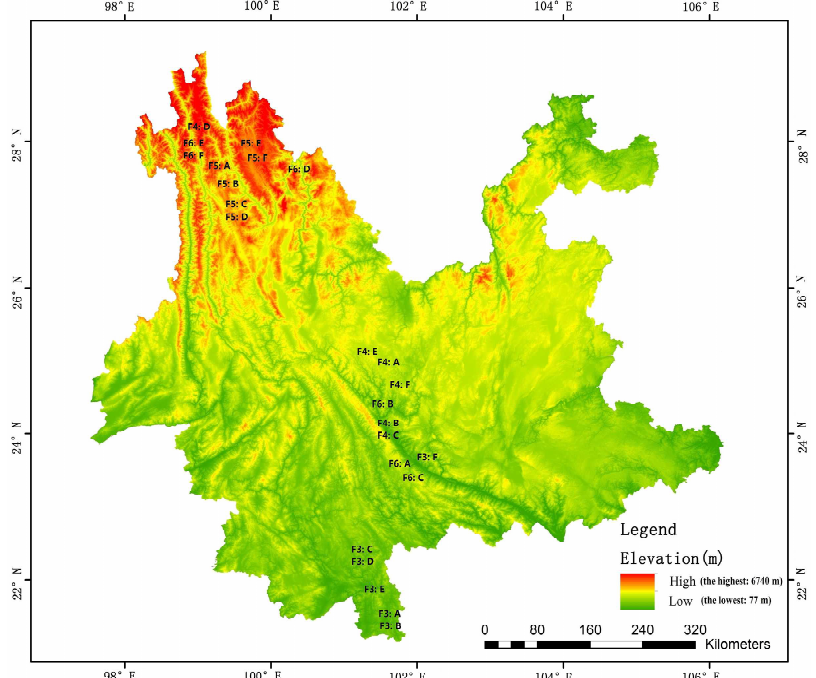
Figure 2. Topography of Yunnan with photo sites taken for vegetation types (this figure was made by the Landscape Ecology Lab., Xishuangbanna Tropical Botanical Garden, CAS; F3, F4, F5, F6 in the map are the shortening of legends in Figures